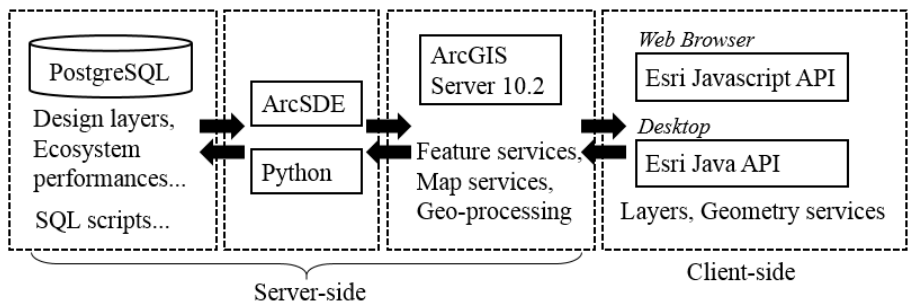
Figure 5. Detailed architecture of the collaborative geodesign